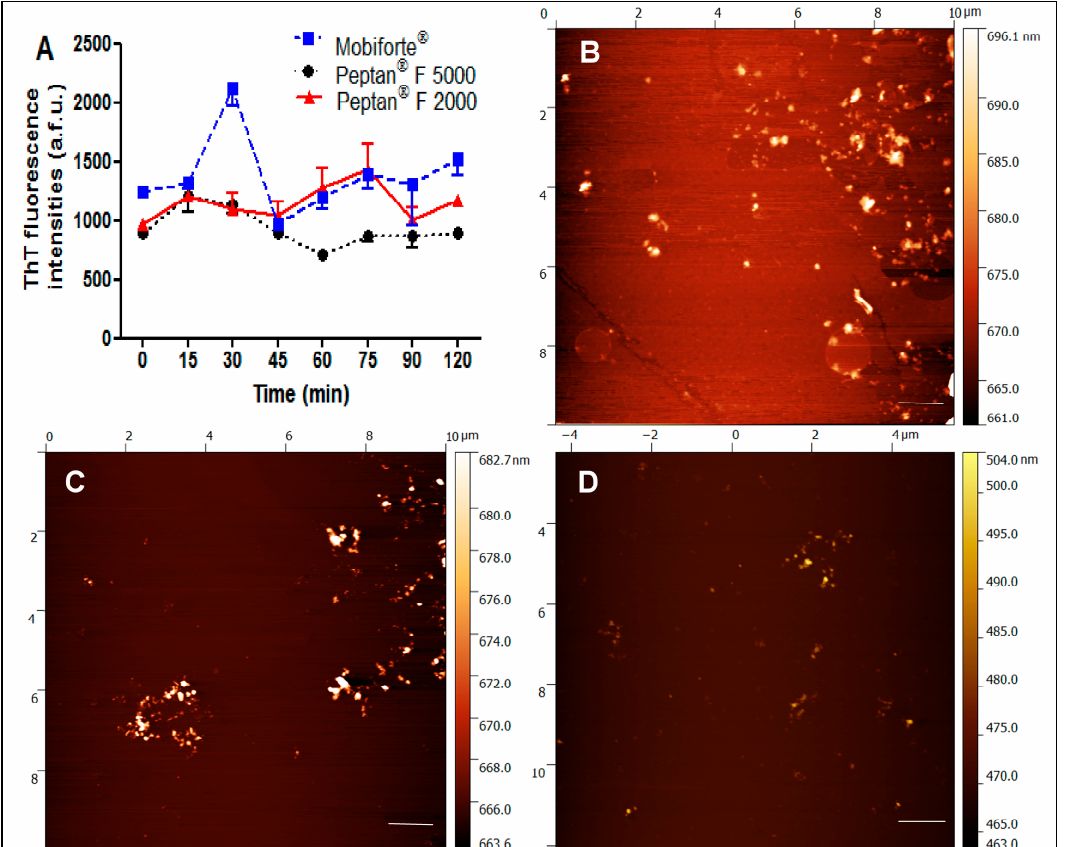
Figure 3. Fibrillization and atomic force microscopy images of CHs. ( A ) Time dependence of fibrillization of three types of CHs monitored by the ThT fluorescence assay. The error bars represent the average deviation for repeat measurements of three separate samples. Peptan ® F 5000 ( black circles ), Peptan ® F 2000 ( red triangles ) and Mobiforte ® ( blue squares ); ( B – D ) Atomic force microscopy images of the CHs: Peptan ® F 5000 ( B ); Peptan ® F 2000 ( C ); and Mobiforte ® ( D ). Images were taken after treatment under neutral conditions at pH 6.0 and 65 °C as described in the Materials and Methods. Bars represent 1 µm.